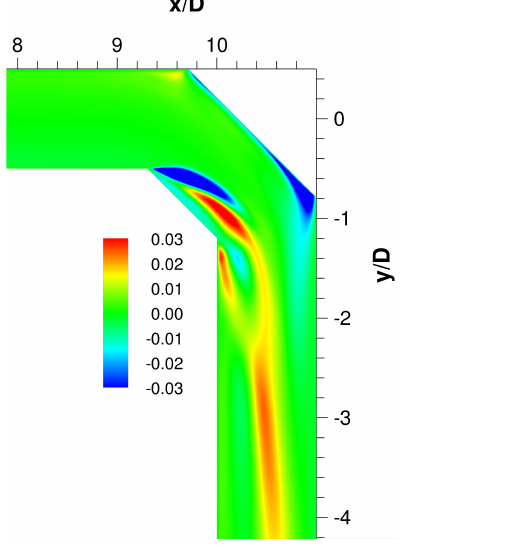
of the 45 ◦ case in the x – y b